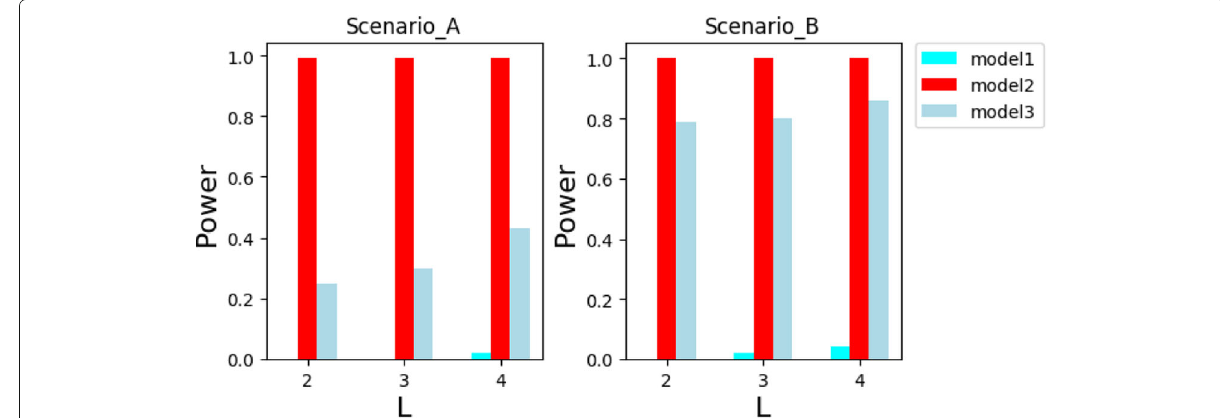
Fig. 4 050501( MAF = 0.5, λ = 0.5, r 2 = 1)